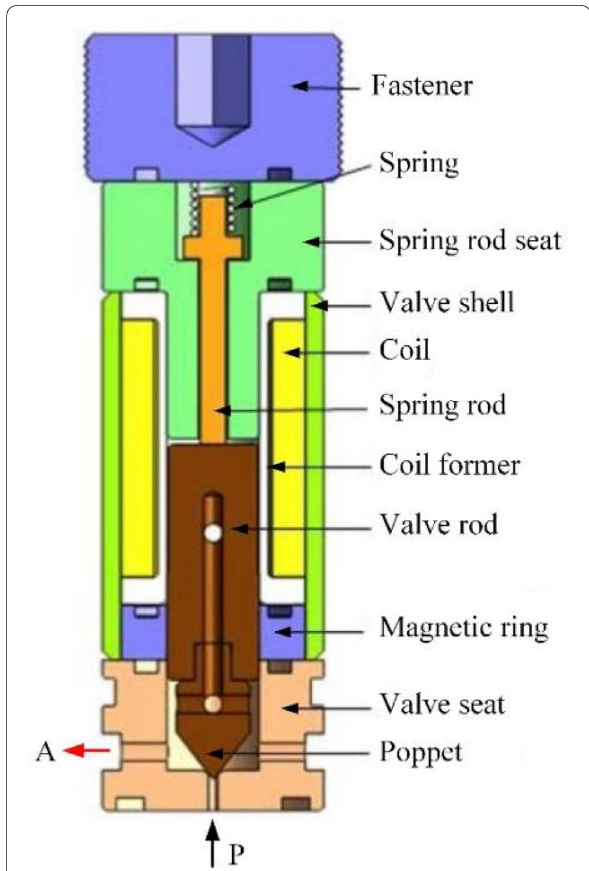
Figure 9 Miniature poppet valve with a magnetic ring provided by Yang et al.